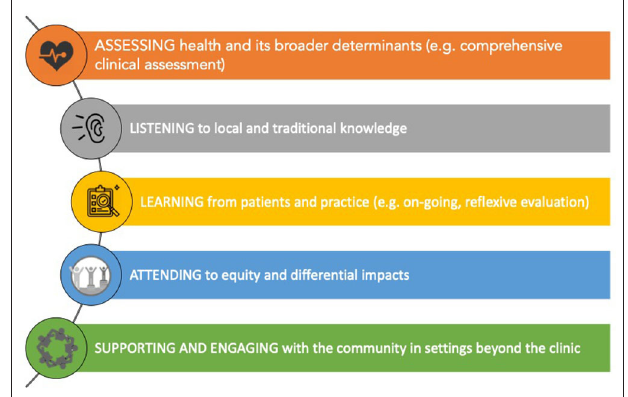
FIGURE 1 | Extending clinical competencies to support the treatment of “communities as patients” in rural and remote places.